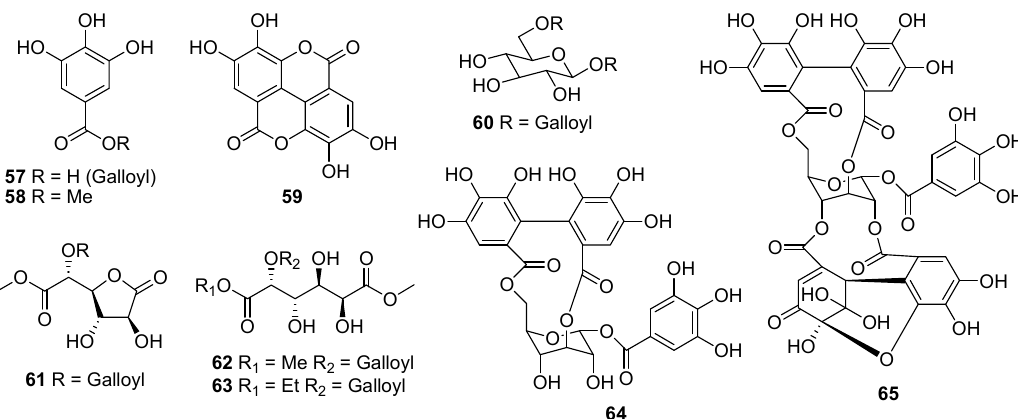
Figure 3. Phenolic compounds from various Phyllanthus species.